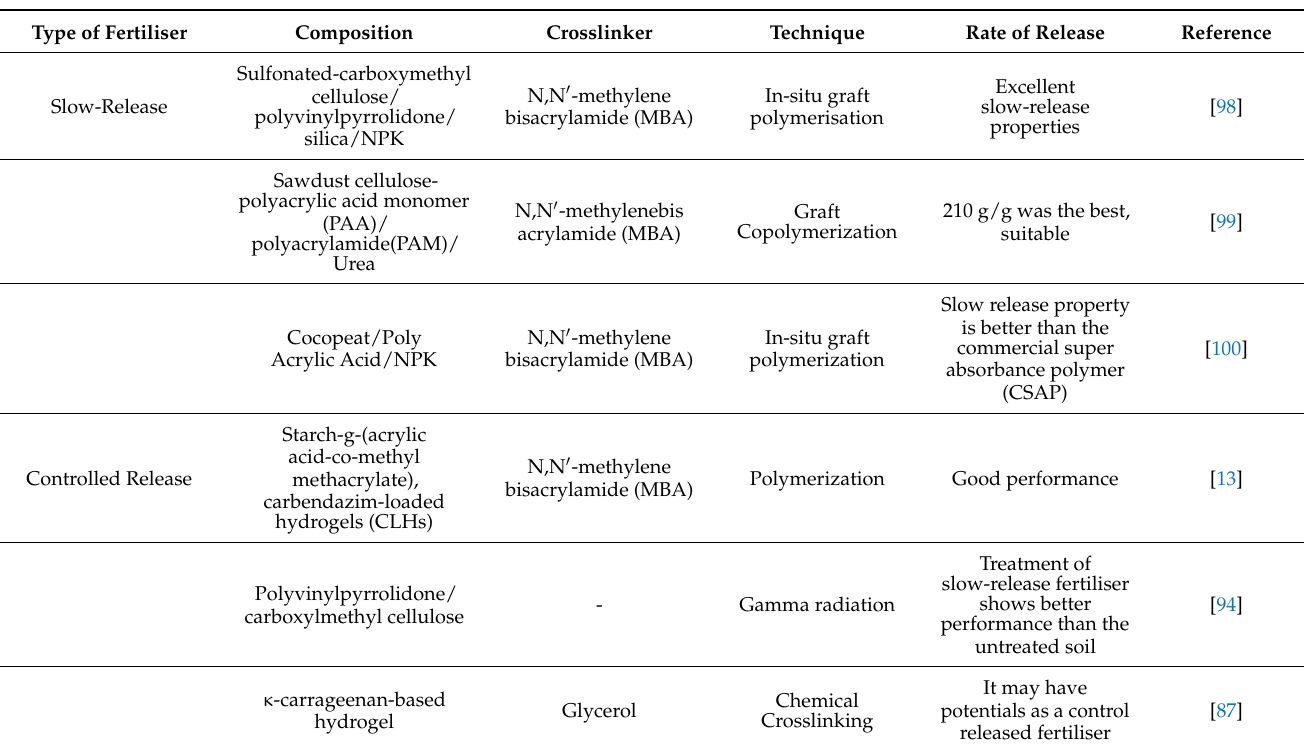
Table 2. Examples of slow-release and controlled-release fertilisers